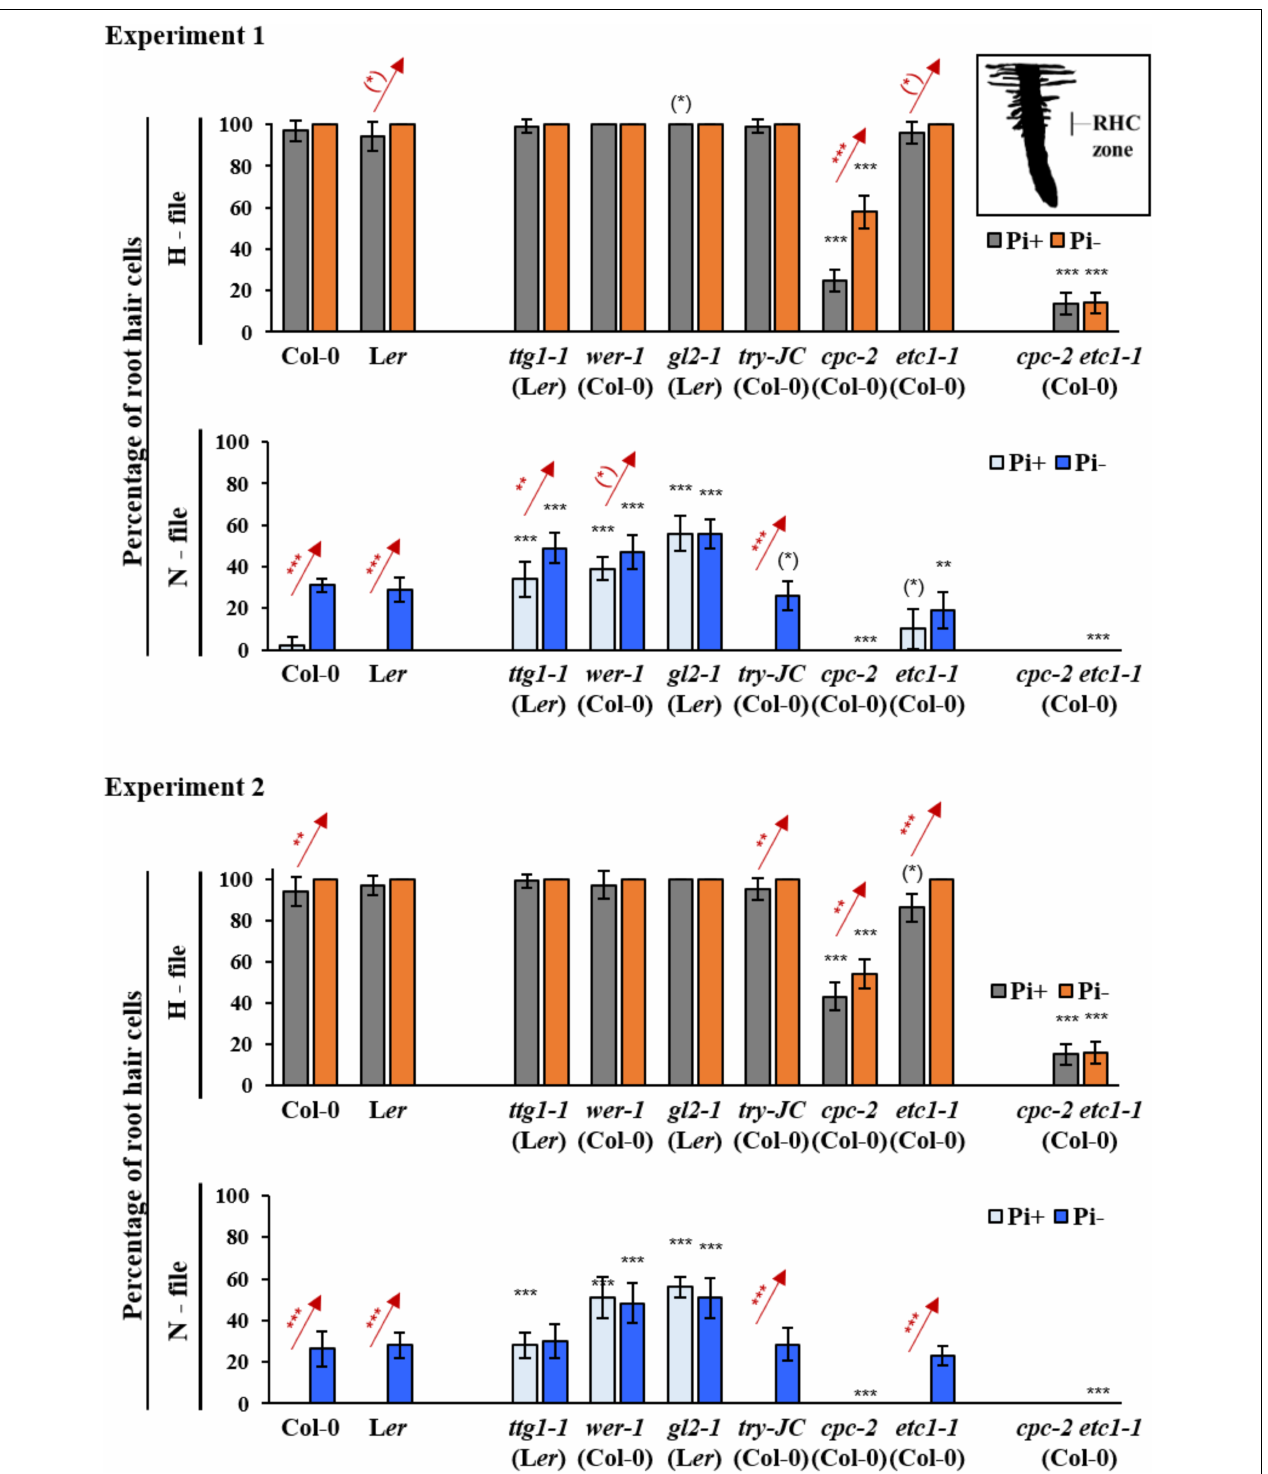
FIGURE 1 | Quantitative analysis of root hair formation in response to phosphate starvation in wild type and mutant genotypes. Two independent experiments are shown in which root hair number is compared in N- and H files between at least 10 wild type and mutant seedlings under normal conditions and under phosphate starvation conditions. RHC zone indicates the region of root hair analysis. Red stars indicate a significant difference between Pi+ and Pi– conditions at ∗ p < 0.5, ∗∗ p < 0.01, ∗∗∗ p < 0.001 (Wilcoxon test). Black stars indicate a significant difference between wild type and mutants at ∗ p < 0.5, ∗∗ p < 0.01, ∗∗∗ p < 0.001 (Wilcoxon